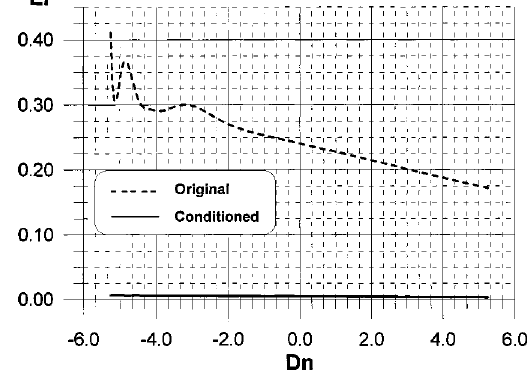
Fig. 14. Residual Error function for variations of the drag force co- efficient C d .